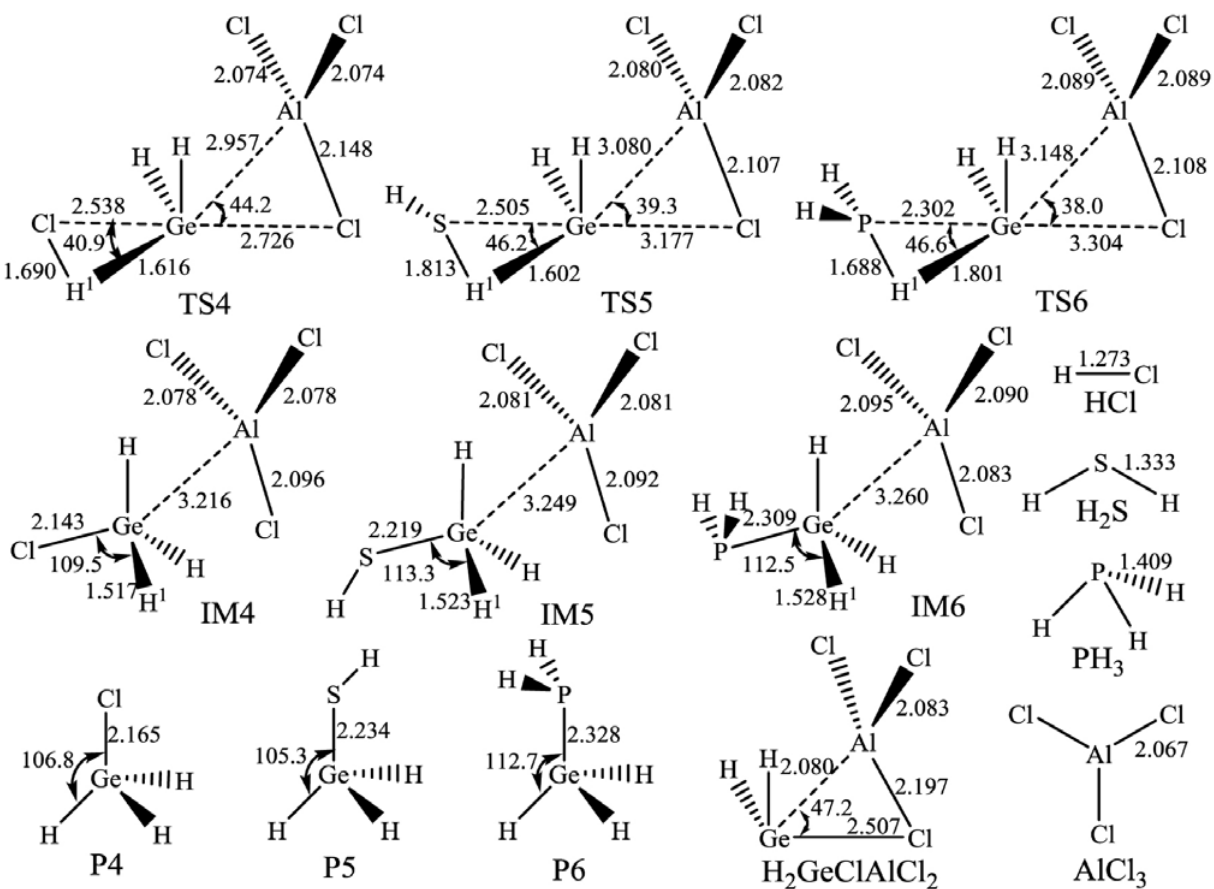
Figure 3. The geometries of the stationary points [ reactants, transition states (TSs), intermediates (IMs), and products (Ps) ] of the substitution reac- tions of the germylenoid H GeClAlCl with HCl, H S, and PH in gas phase calculated at MP2/6-311+G ( d , p ) level (Bond lengths are given in Å 2 2 2 3 and angles in